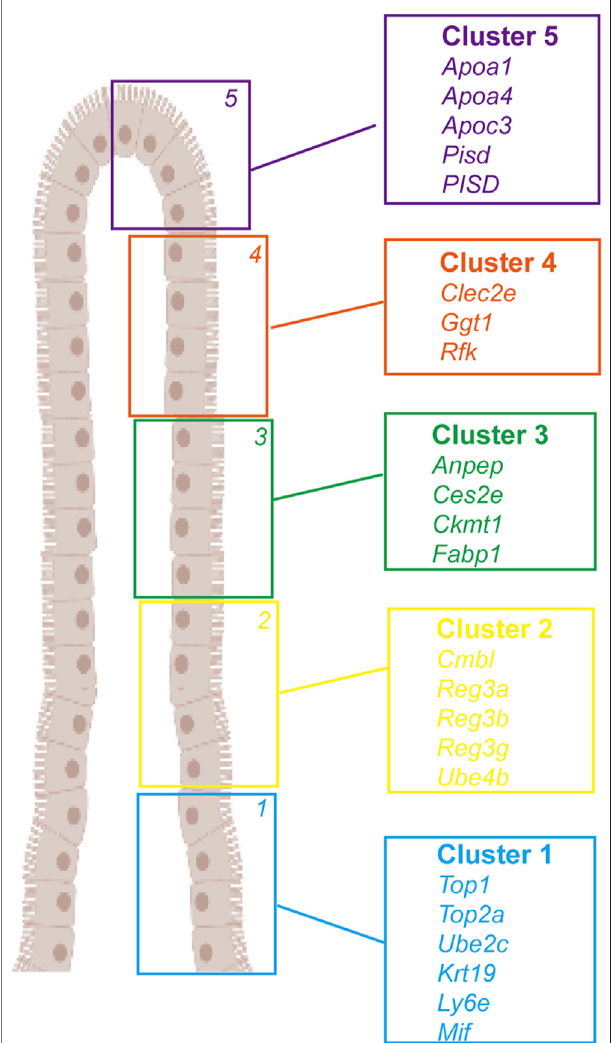
FIGURE2| Landmarkgenesofenterocytealongthevillus.Alargepanel of landmark genes uncovers broad zonation of enterocyte function along the villus. Cluster 1: Top1, Top2a, Ube2c, Krt19, Ly6e, and Mif. Cluster 2: Cmbl, Reg3a, Reg3b, Reg3g, and Ube4b. Cluster 3: Anpep, Ces2e, Ckmt1, and Fabp1. Cluster 4: Clec2e, Ggt1, and Rfk. Cluster 5: Apoa1, Apoa4, Apoc3, Pisd, and